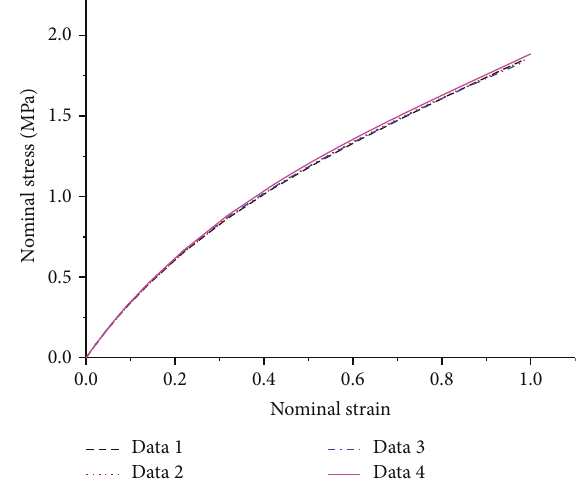
Figure 9: Stress-strain curves of di ff erent stochastic models with di ff erent particle sizes for NSBR6 in case of uniaxial